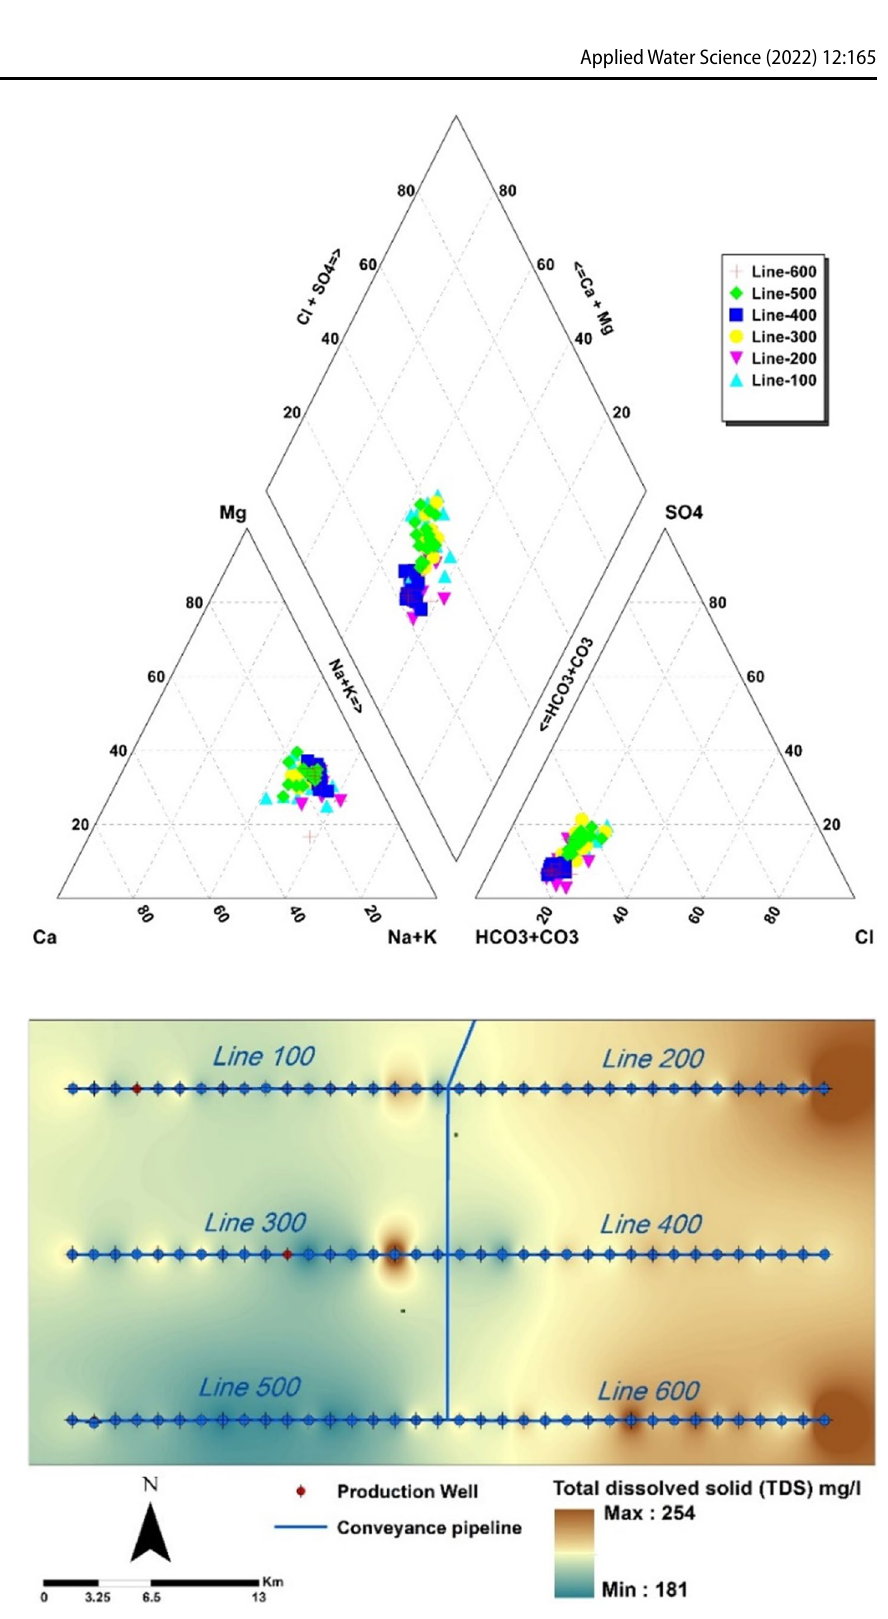
Fig.10 Piper diagram for the wellfield water wells